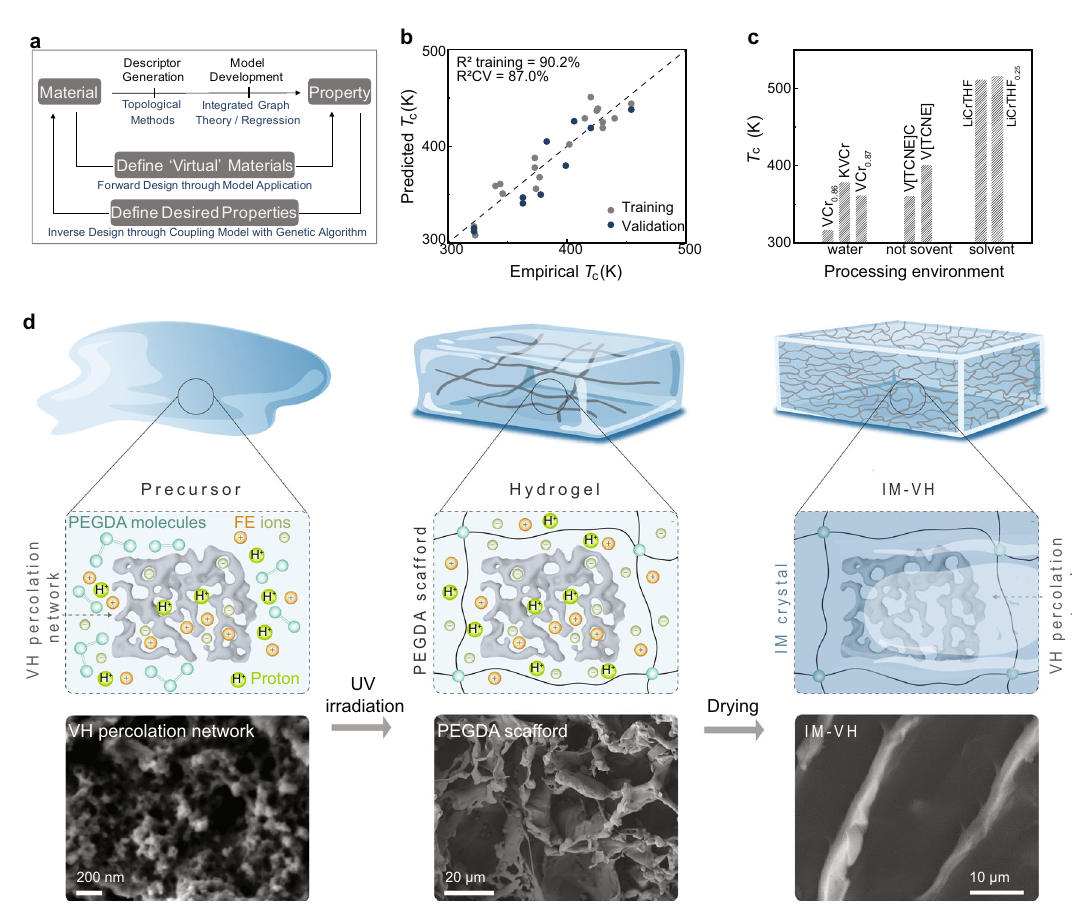
Fig. 2 Machine learning design results and solid-solution method for preparing molecular heterogeneous solids. a Data-driven computational materials design at the scale of microstructure enabled by supervised machine learning. Training and testing datasets consist of data for each molecular ferroelectric. The machine learning model, typically consisting of a descriptor transformation, a learning algorithm, and an evolutionary inspired optimization aims to discover a statistically correct predictive model from training datasets. b Results of the empirical T c value (measured data) versus the predicted T c value of molecular ferroelectrics from the machine learning models. In all cases, the models are accurate, robust, and can be extended to any molecular system. c T c and processing environment for selected high-temperature molecular magnets. VCr 0.86 (V[Cr(CN) 6 ] 0.86 · 2.8H 2 O); KVCr (KV[Cr(CN) 6 ]·2H 2 O); VCr 0.87 (V [Cr(CN) 6 ] 0.87 · 1.6H 2 O); V[TCNE]C (V[TCNE] x ·yCH 2 Cl 2 ); V[TCNE] (V[TCNE] x ); LiCrTHF (Li 0.7 [Cr(pyz) 2 ]Cl 0.7 ·(THF)); LiCrTHF 0.25 (Li 0.7 [Cr(pyz) 2 ] Cl 0.7 ·0.25(THF)). d Schematic diagram for the hydrogel-based method for the multiferroic composites. The hydrogel sample with the desired proton, FE ions, and MA nanoparticles can be obtained by directly printing from the precursor. The crystallization process for the IM-VH is performed based on the printed hydrogel which was dried in a nitrogen show a shift of 8 nm suggesting the interfacial interaction of IM